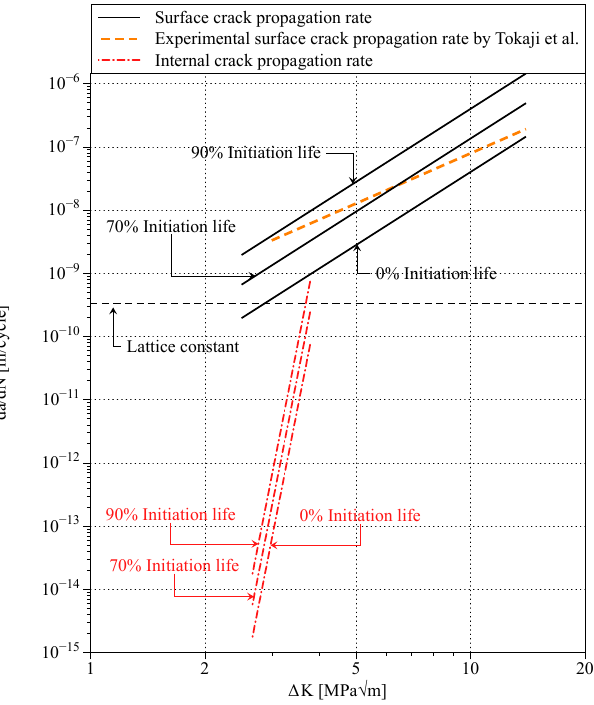
Figure 15. Relationship between crack propagation rate and stress intensity factor range derived from the Tanaka-Akiniwa model in terms of fracture mode and crack initiation life.